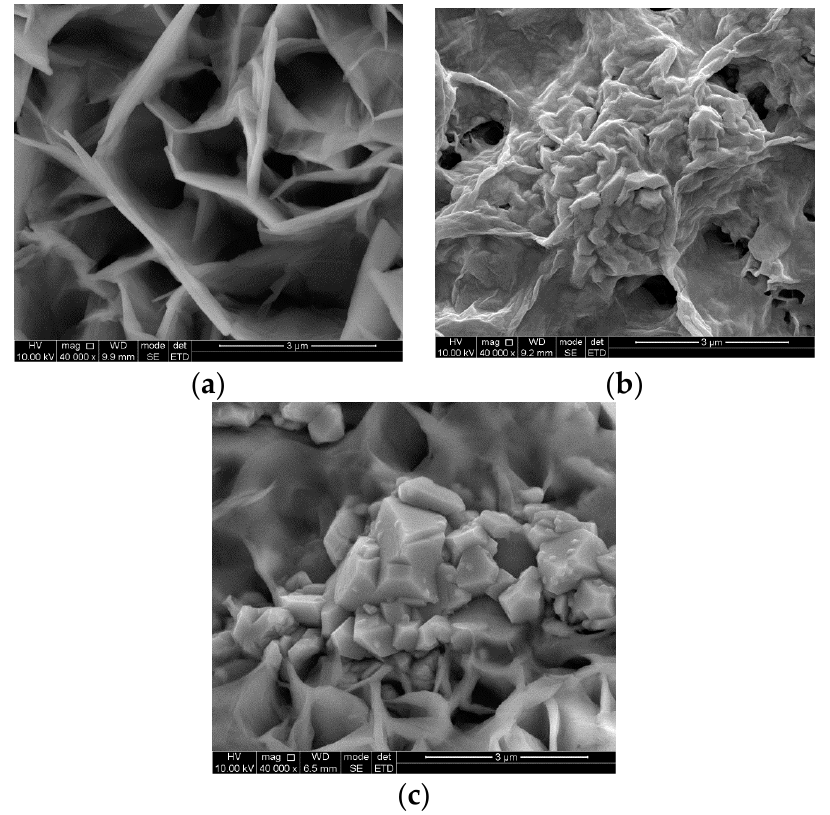
Figure 1. The scanning electron microscopy (SEM) of ZnO ( a ), Cu 2 O ( b ), and ZnO-Cu 2 O ( c ) sample.